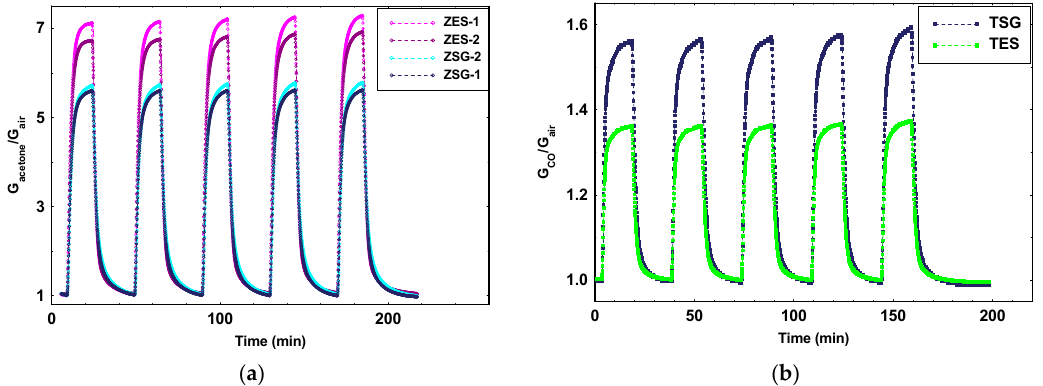
Figure 4. Dynamic responses to 1 ppm of acetone for ZES and ZSG sensors reported as G acetone /G air ( a ) and 2 ppm of carbon monoxide for TSG and TES sensors reported as G CO /G air ( b